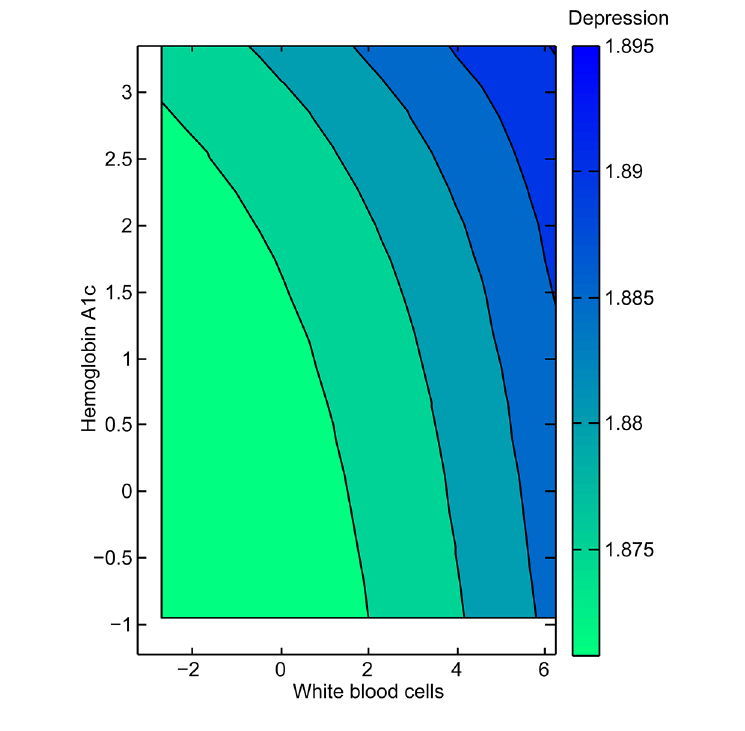
figure 5. Triple association of hemoglobin A1c, inflammation and depression scores. Association of Hemoglobin A1c, white blood cells counts (WBCC) and depression score (PHQ). Each score presents the differences between the observed and expected value for individuals with the same age, gender and BMI. Depression scores (color code) were Square-root transformed. Note the increasing tendency for depression (blue) in those participants with higher values of both hemoglobin A1c and